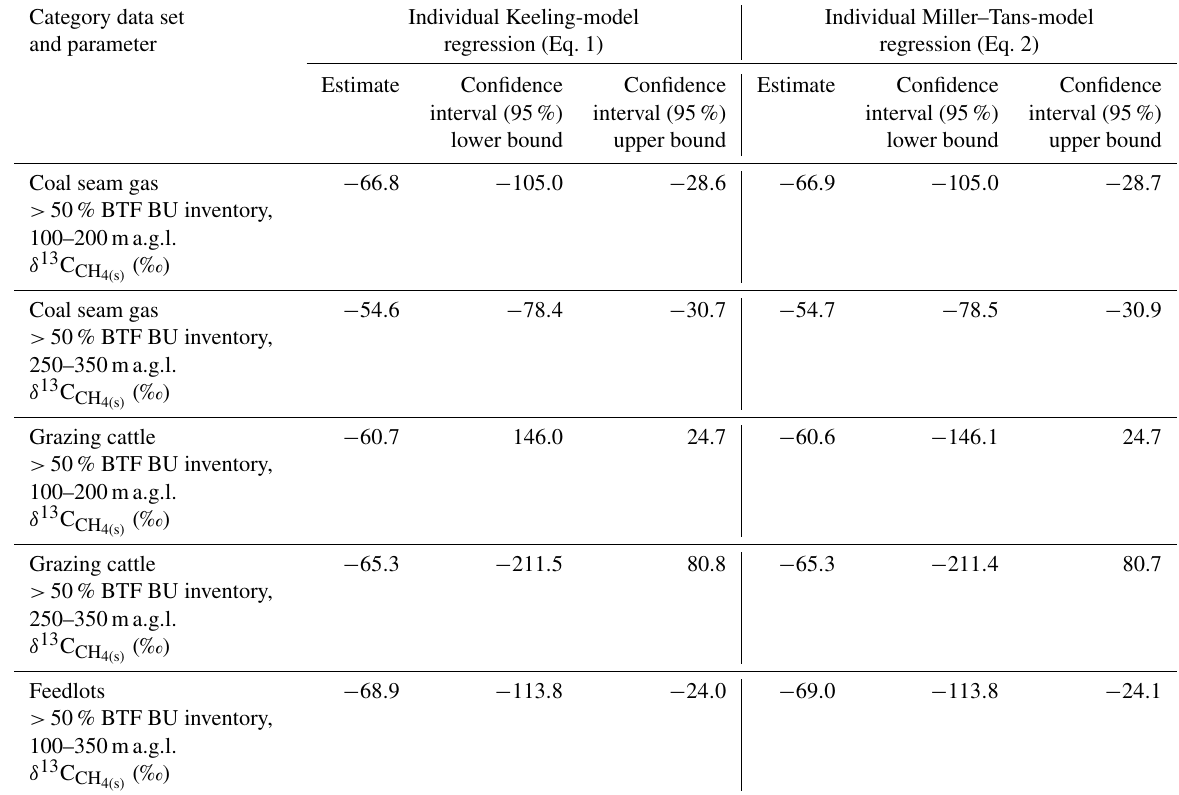
values for Keeling model (Eq. 1) and Miller–Tans model (Eq. 2) fitted to the individual source category Table B1. Calculated δ 13 C CH 4(s) data sets. Category data